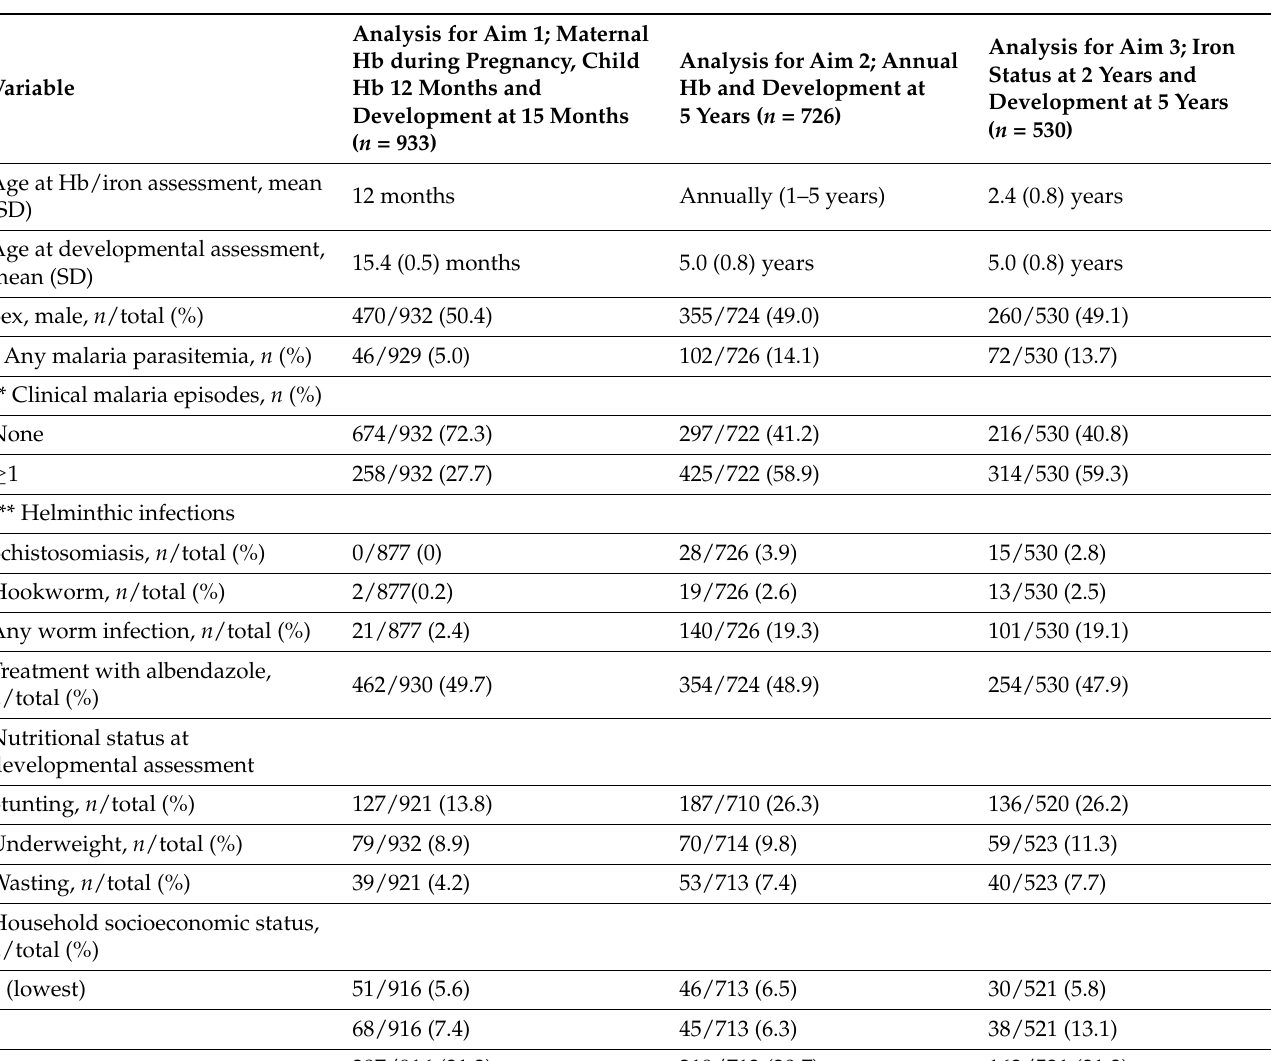
Table 1. Participant